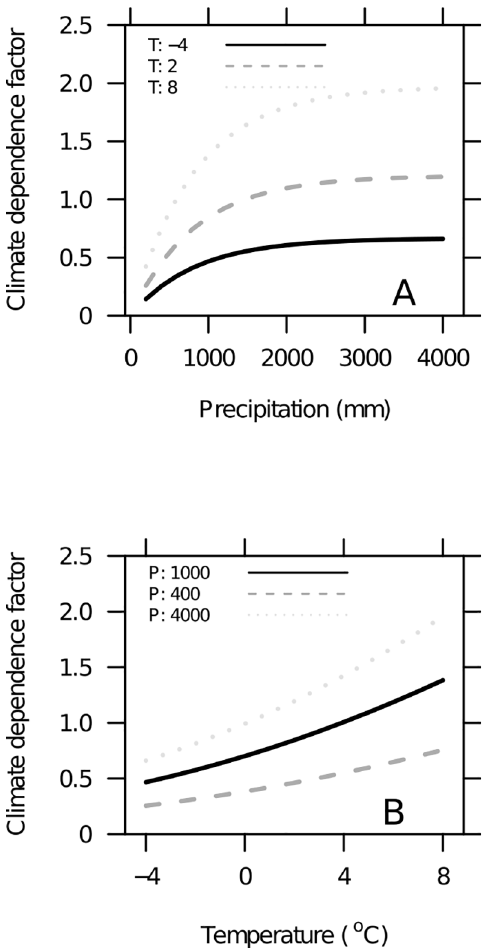
Fig 2. Climate dependence factors for decomposition in Yasso07 representing the climatic range in Norway. (A) Dependence factors (Eq 1) for three fixed values of mean annual temperature, T (-4, 2 and 8°C, respectively). At constant T, dependence factors increase with increasing precipitation up to a finite asymptotic value and become practically independent from P once it exceeds 1500 mm per year. (B) Dependence factors (Eq 1) for three fixed values of precipitation, P (400, 1000, 4000 mm,